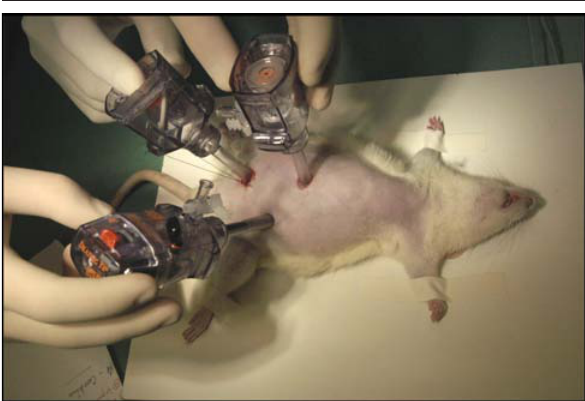
FIGURE 2 - Positioning and fixing of trocars